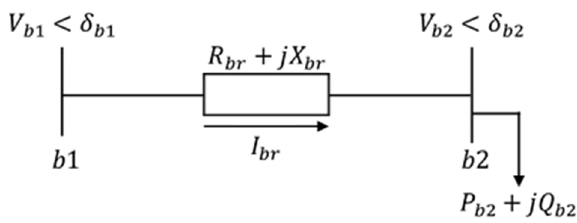
Figure 2. Single-line diagram of two-bus distribution network.